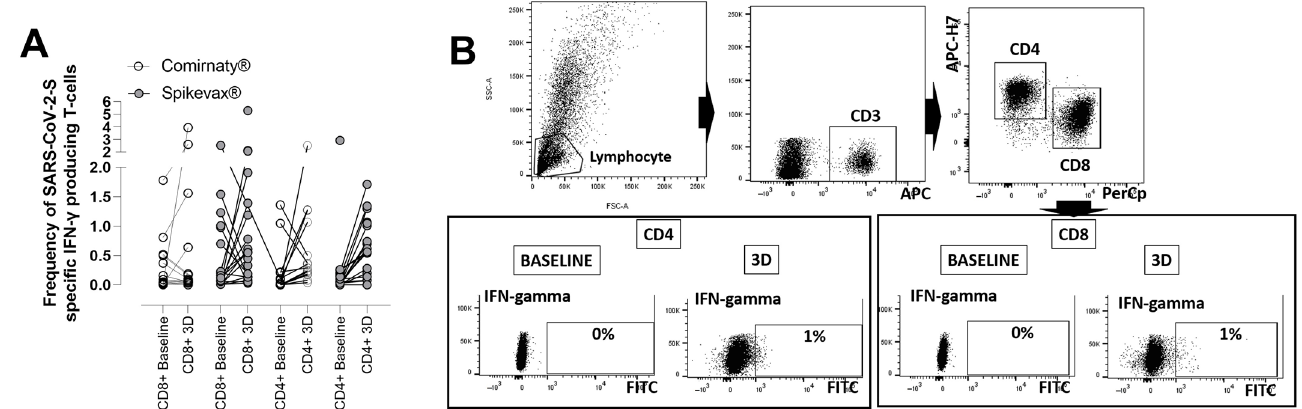
Figure 5. ( A ) Frequencies of SARS-CoV-2-S- IFN- γ producing T cells in whole blood in hemodialysis patients after receipt of an homologous mRNA COVID-19 third dose (3D), either Comirnaty ® or Spikevax ® , relative to those measured at baseline ( B ). Example of an intracellular cytokine staining (ICS) dot plot showing CD4 and CD8 frequencies at baseline and after receipt of a third dose.